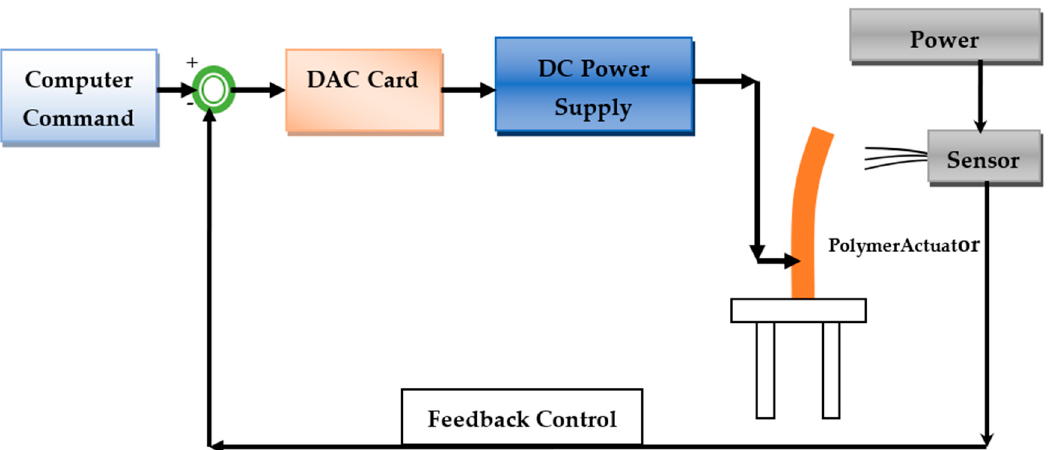
Figure 2. Basic layout for actuation and control of the SPVC − PTA − Pt polymer actuator. × 10 mm × 0.2 mm) was fixed in The polymer actuator membrane (ca. 30 mm × 10 mm × 0.2 mm) was fixed in a holder The polymer actuator membrane (ca. 30 mm